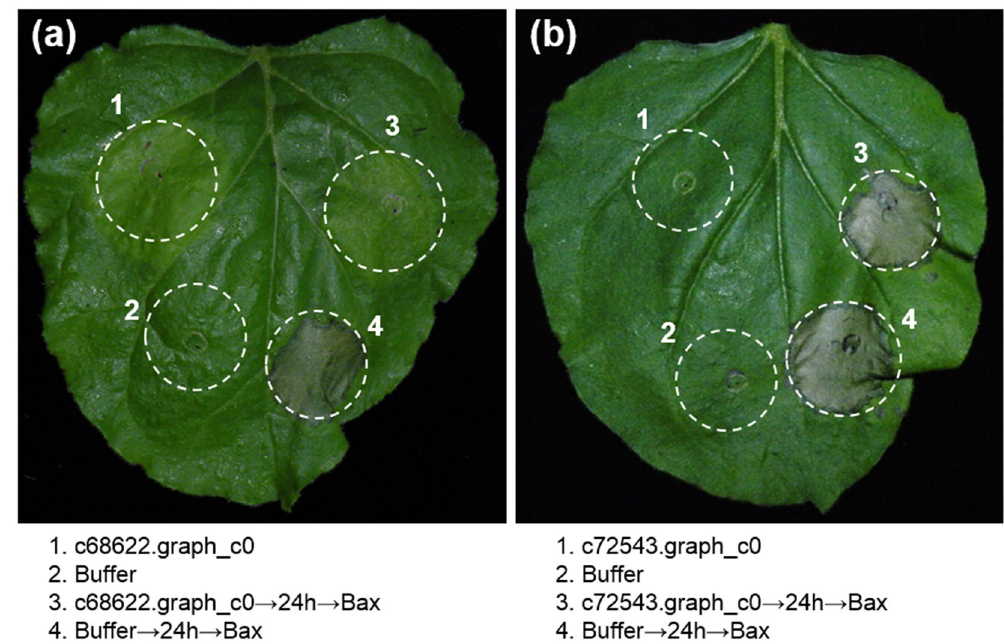
Figure 8. Assay for suppression of BAX-triggered cell death (BT-PCD) by the candidate Heterodera avenae effectors ( a ) c68622.graph_c0 and ( b ) c72543.graph_c0 in Nicotiana benthamiana . Leaves of N. benthamiana were infiltrated with the infiltration buffer or Agrobacterium tumefaciens cells containing a pGR107 vector carrying the candidate effector gene either alone or infiltration with A. tumefaciens cells carrying a mouse Bax gene 24 h later. Photos of the phenotypes of infiltrated N. benthamiana leaves were taken 6 days after infiltration. The spots with label 3 on the leaf show that the gene c68622.graph_c0 suppressed the necrosis induced by Bax , but the gene c72543.graph_c0 did not suppress